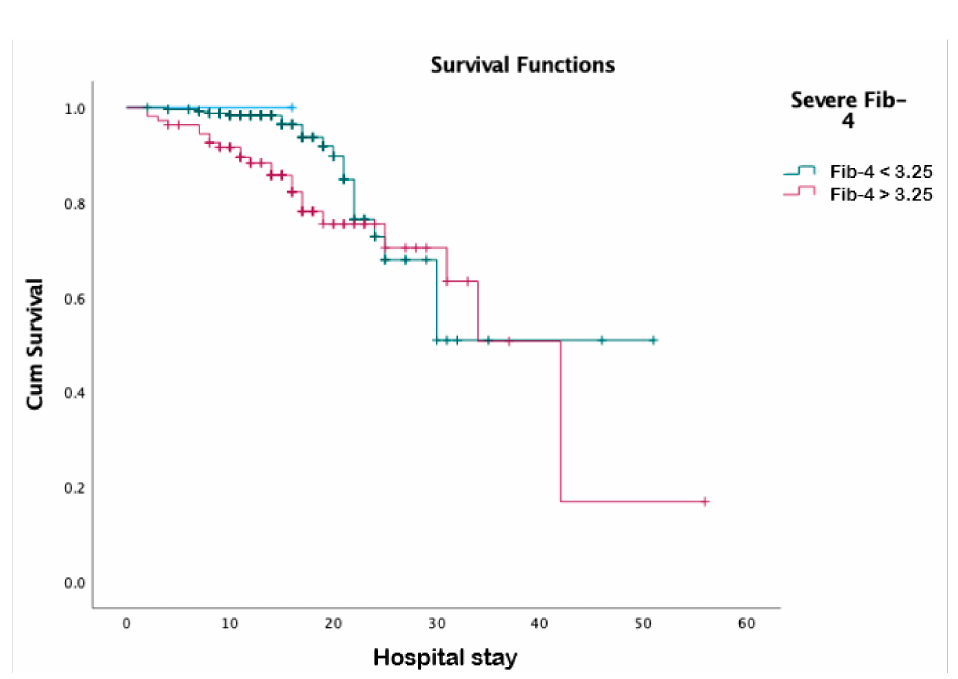
Figure 1. Survival analysis for severe FIB-4 score, defined as FIB-4 > 3.25. We also analyzed the AUROC curves for the fibrosis scores (Figure 2) and found that FIB-4 had the best predictive value for survival, with an area under the curve (AUC)